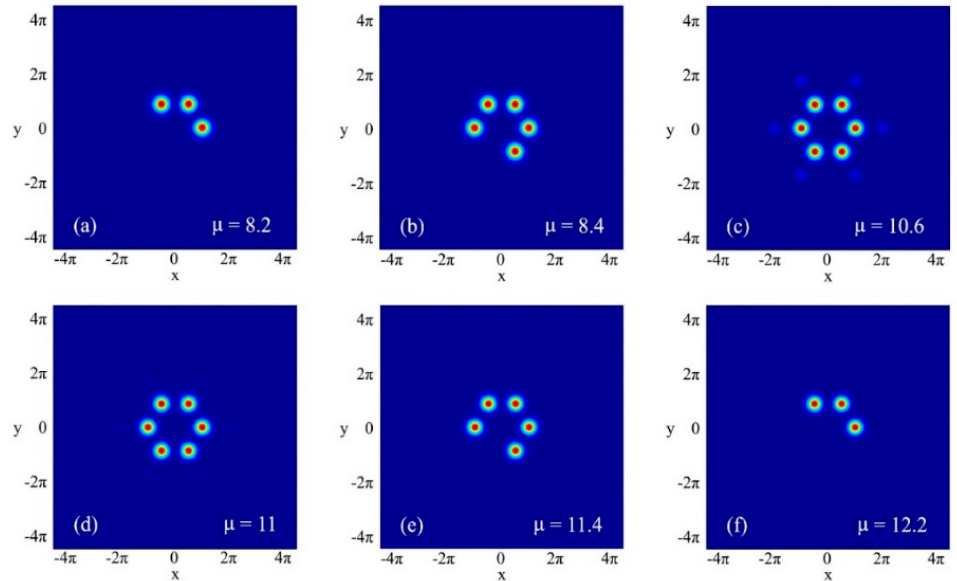
Figure 12. The evolution of the profiles of vortex solitons with m = 3, d = 0.5. ( a – f ) are the profiles of the vortex solitons with µ = 8.2,8.4,10.6,11,11.4,12.2, respectively. The upper row corresponds to solitons in the first bandgap, while the lower row corresponds to solitons in the infinite